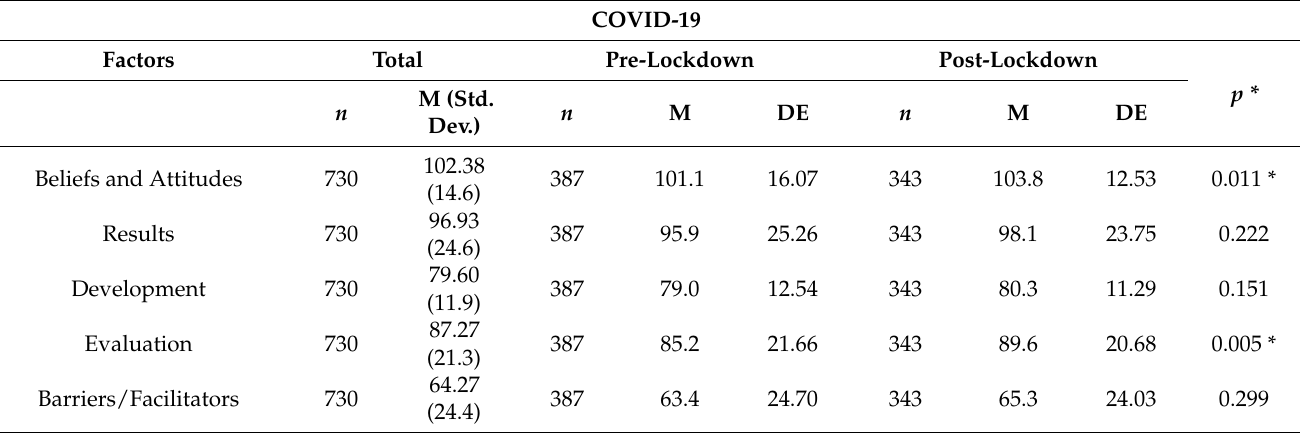
Table 5. Descriptive and inferential analysis of the subscales (HS-EBP 30) between the pre- and post-lockdown groups due to COVID-19.